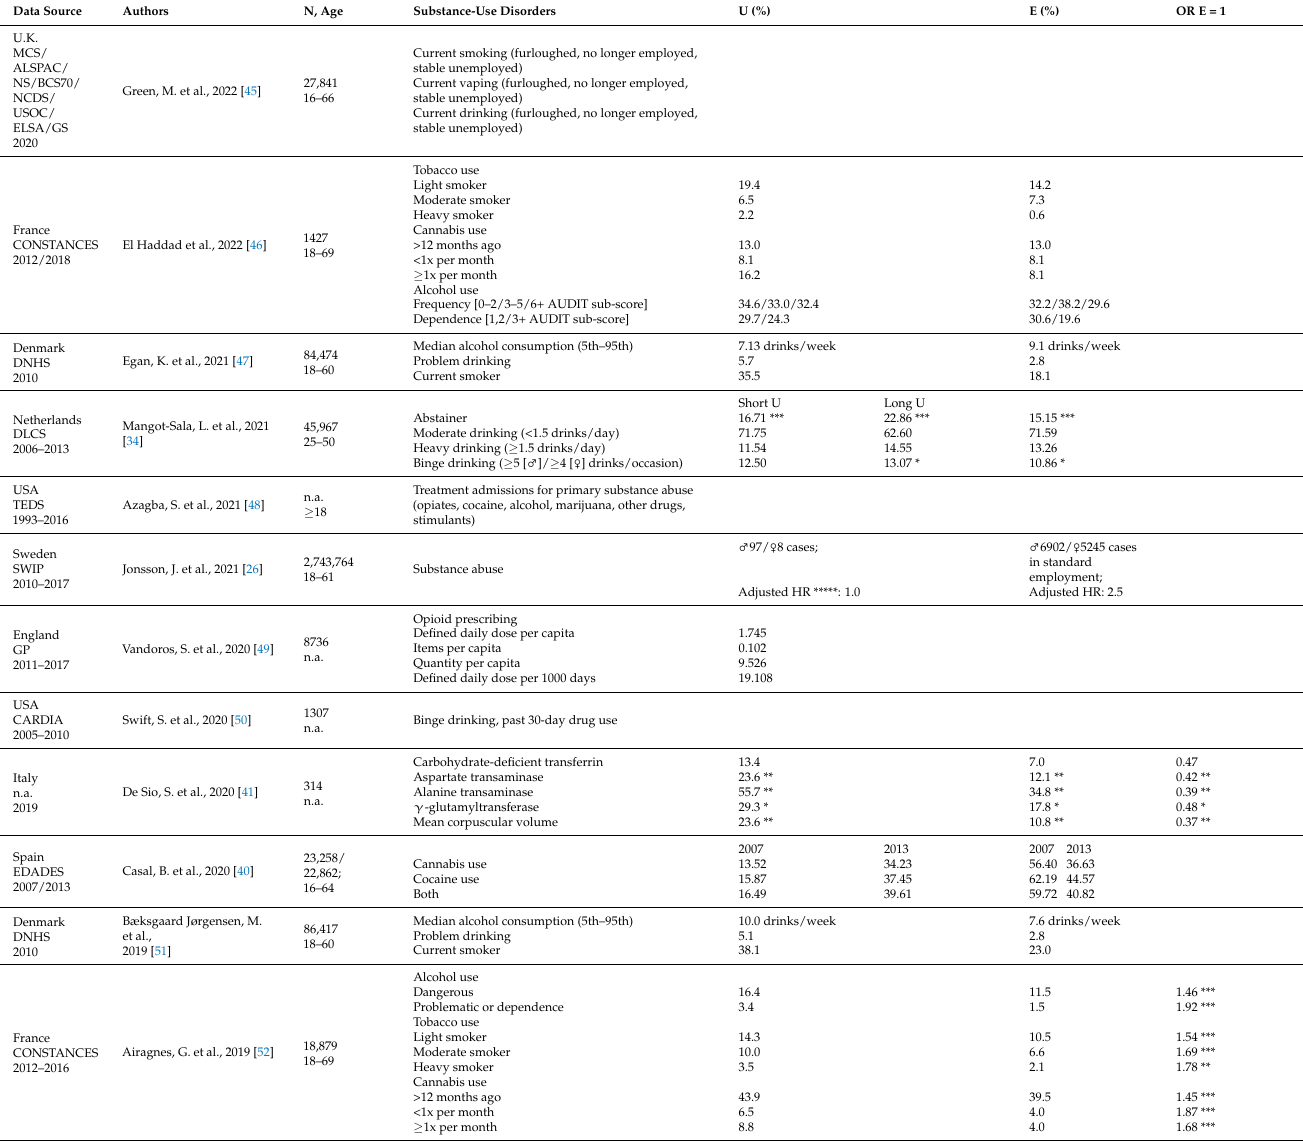
Table 1. Prevalence of Substance Use Disorders Among Unemployed (U) and Employed (E), Preva- lence Rates (%), Odds Ratios